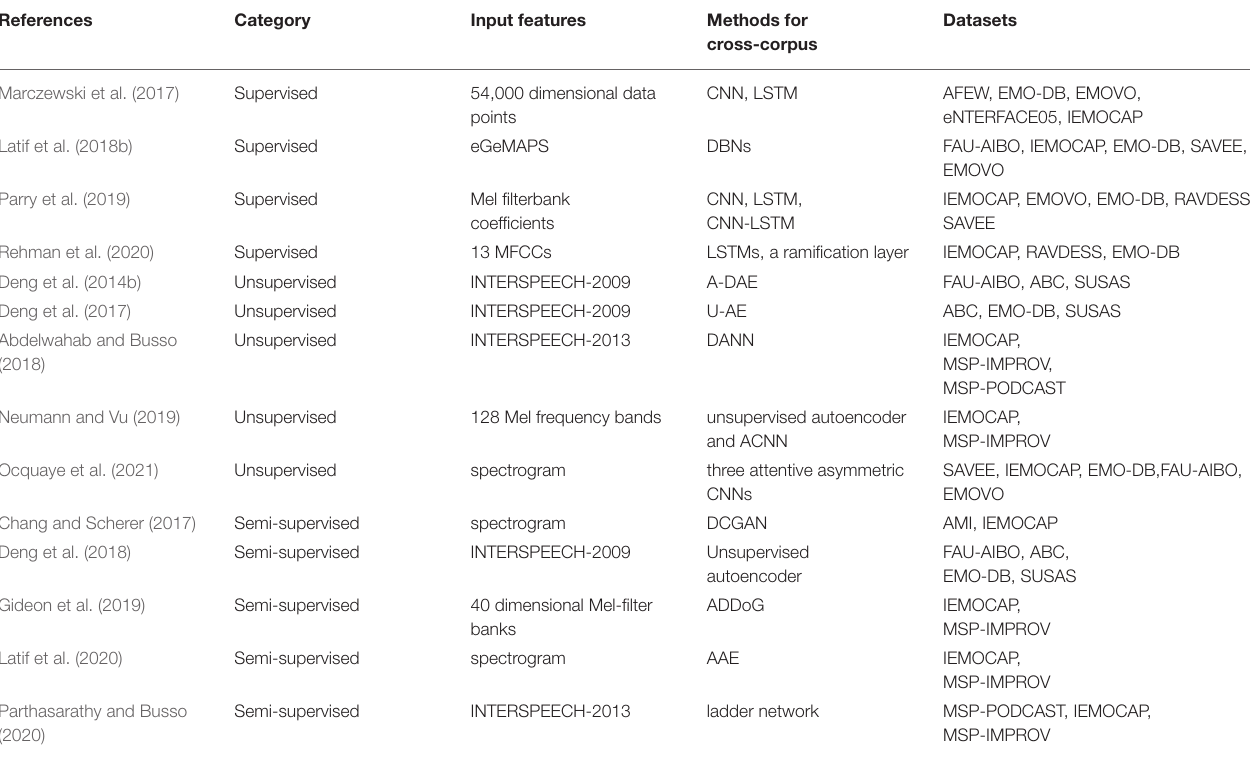
TABLE 3 | A brief summary of existing deep cross-corpus SER